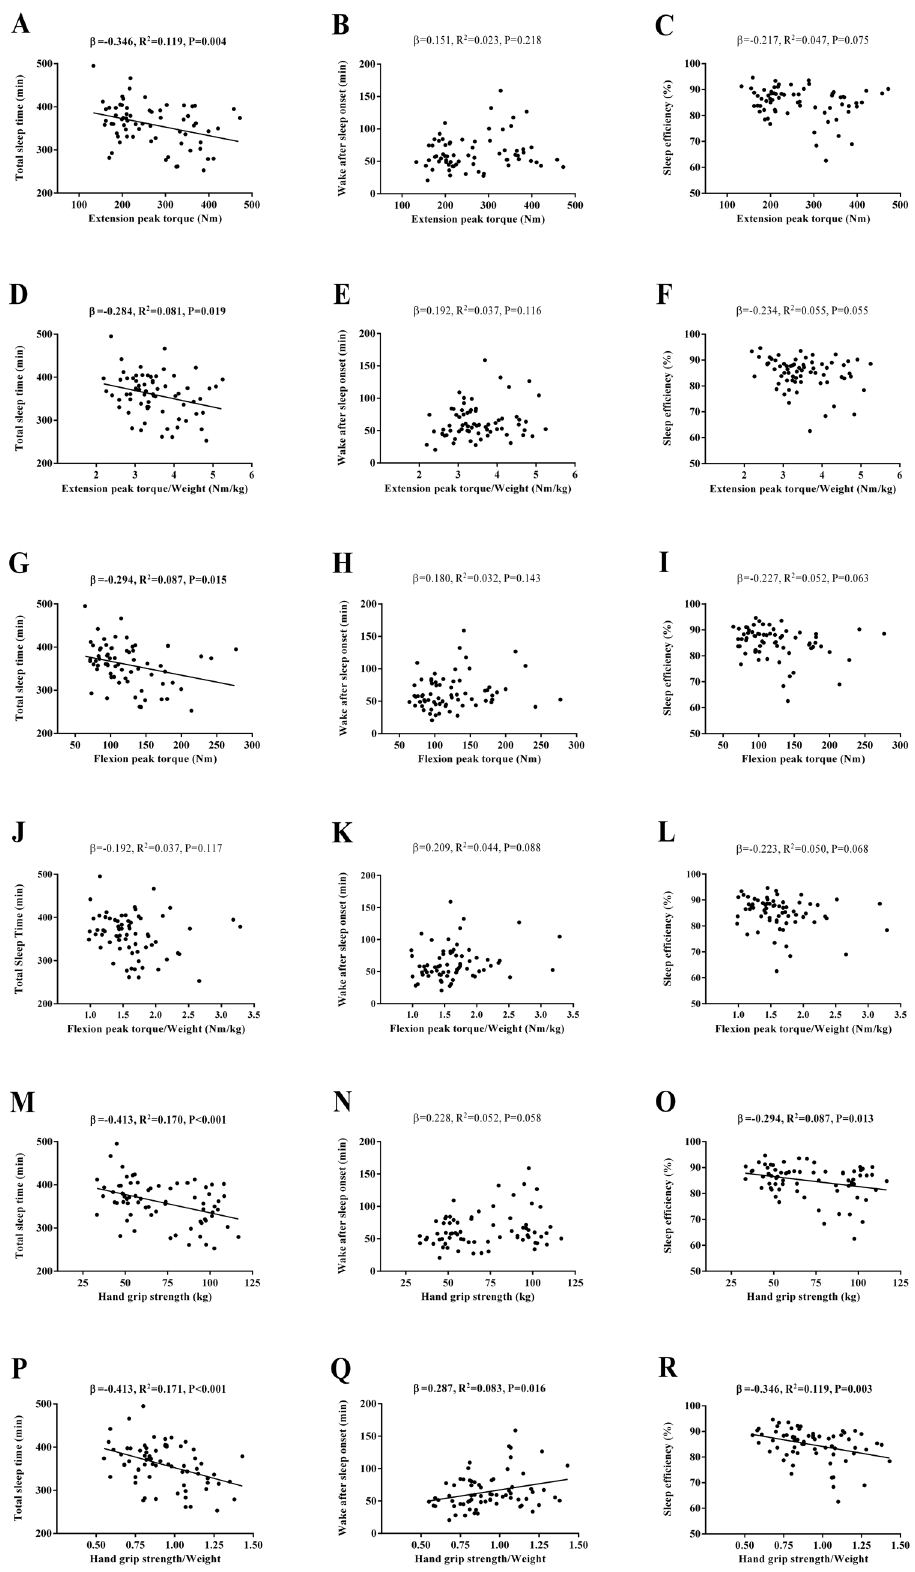
Figure 4. Association of muscular strength with objective sleep quantity and quality in sedentary middle-aged adults. β (standardized regression coefficient), R 2 , and P from a simple linear regression analysis. Significant P values (≤ 0.05) are in